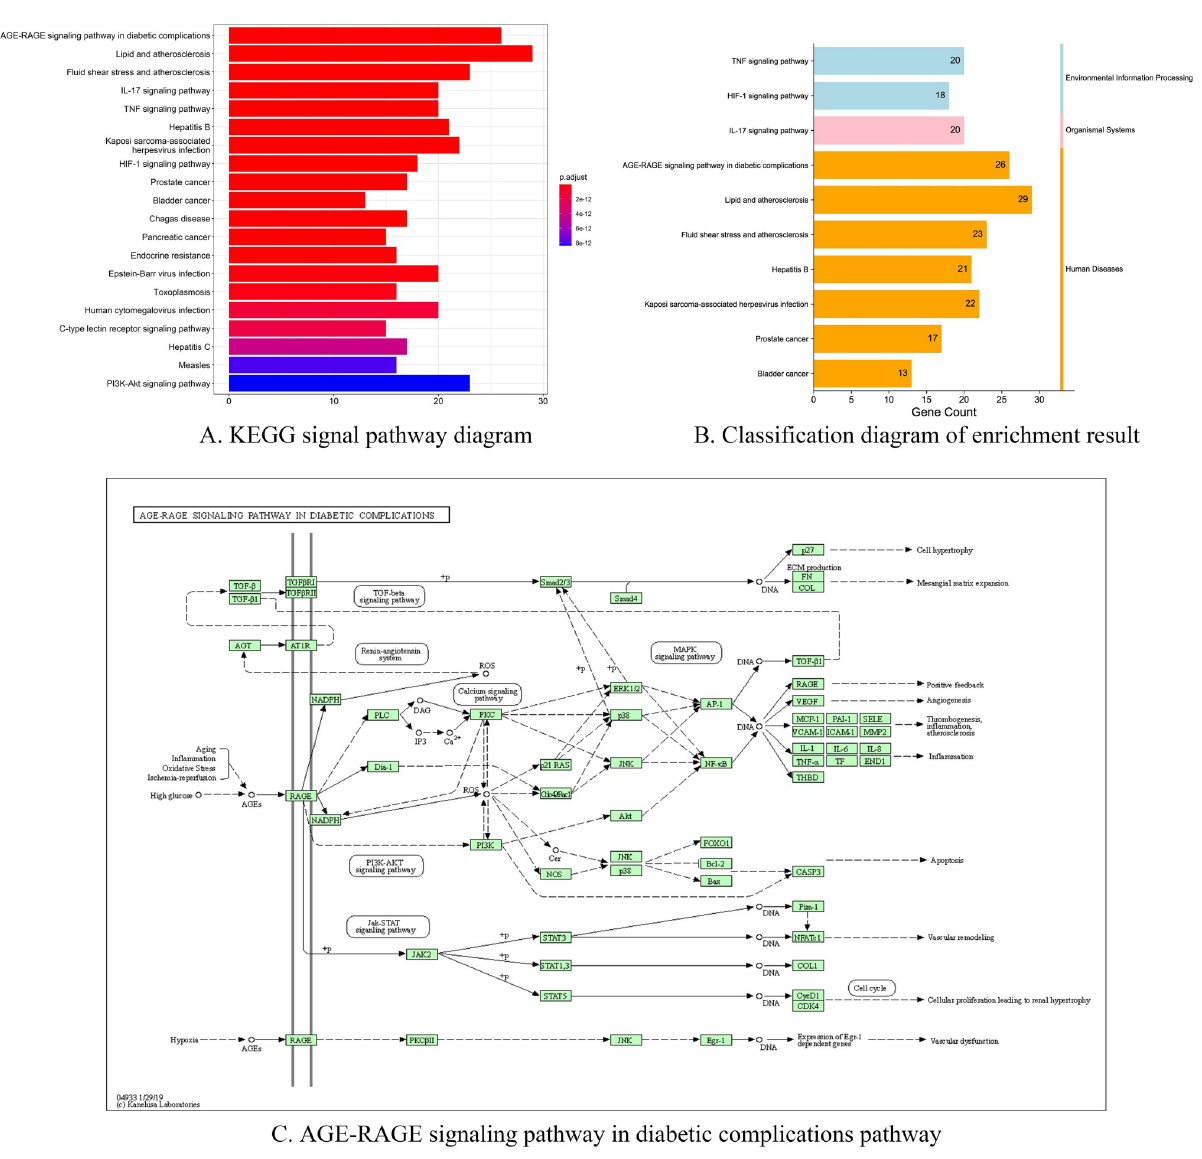
Fig 3. Pathway diagram in KEGG pathway analysis. Note: The ordinate of 3A is the first 20 KEGG pathways enriched, and the colors of 3B represent different classifications. 3C AGE-RAGE signaling pathway in diabetic complications pathway (KEGG ID = Hsa04933).